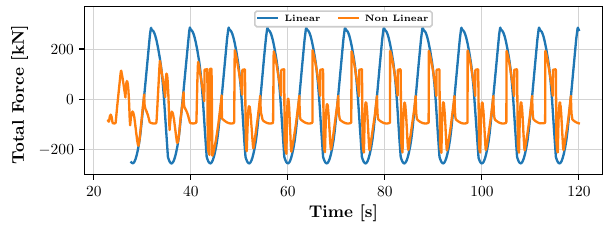
Fig. 14. Total force expresses the sum of the Buoyancy and Froude- Krylov forces in the z-direction, given by the WEC-Sim model using the linear and nonlinear